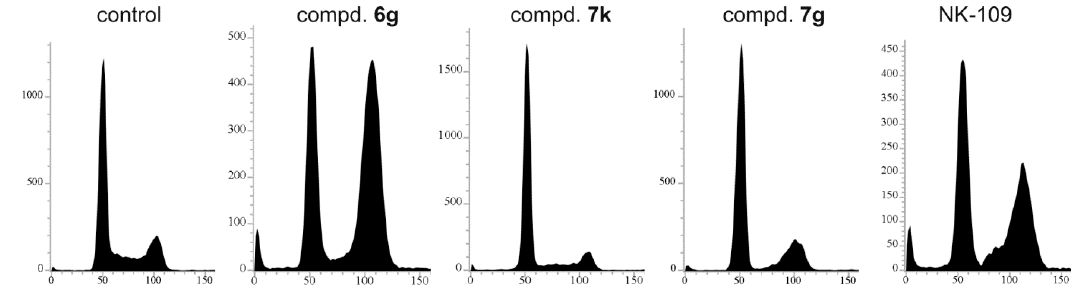
Figure 3. Cell cycle effects of compounds 7k , 7g , 6g and NK-109 in MCF-7 cells treated for 24 h with doses corresponding to 3 × EC 50 values (60, 5.4, 33 and 13.8 µM, respectively). Cells were harvested and then flow cytometric analysis of DNA stained by propidium iodide (10,000 counts) was performed as described in the Materials and Methods section.